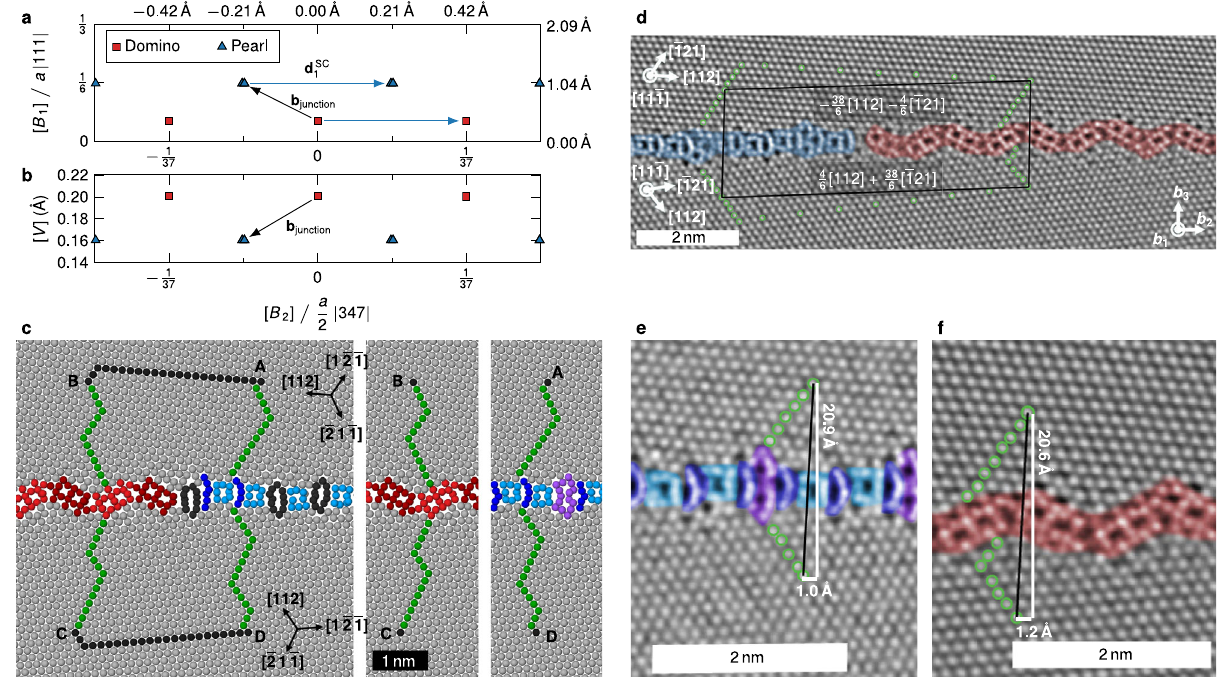
Fig. 7 Burgers vector of the phase junctions. a , b Microscopic translations ½ B (cid:2) between the crystallites for the different phases. The differences in ½ B (cid:2) correspond to the Burgers vector b junction . Different possible ½ B (cid:2) vectors are equivalent, since they are connected by DSC vectors d SC . c Burgers circuit on an actual junction in the simulation. The black lines were chosen to be parallel, so that AB þ CD ¼ 0 . The green lines of the circuit were measured in ideal unit cells of the GB phases to avoid elastic distortions near the junction. d Burgers circuit on the experimental image from Fig. 1a using the same method. e , f The lines crossing the GB were translated to reference segments far away from phase junctions before measuring in order to reduce elastic distortions. The same images as in Fig. 3 were used. The components parallel and normal to the GB were measured to be b k ¼ (cid:3) 0 : 28 to (cid:3) 0 : 45 Å and b ? ¼ (cid:3) 0 : 1 to þ 0 : 14 Å. For more circuits at different phase junctions see Supplementary Fig.